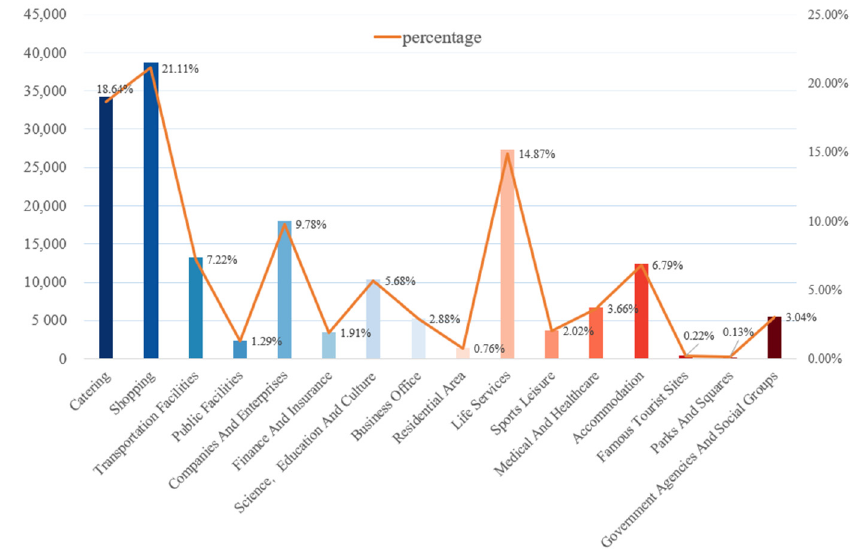
Figure 3. Statistics of the number of classified POIs.